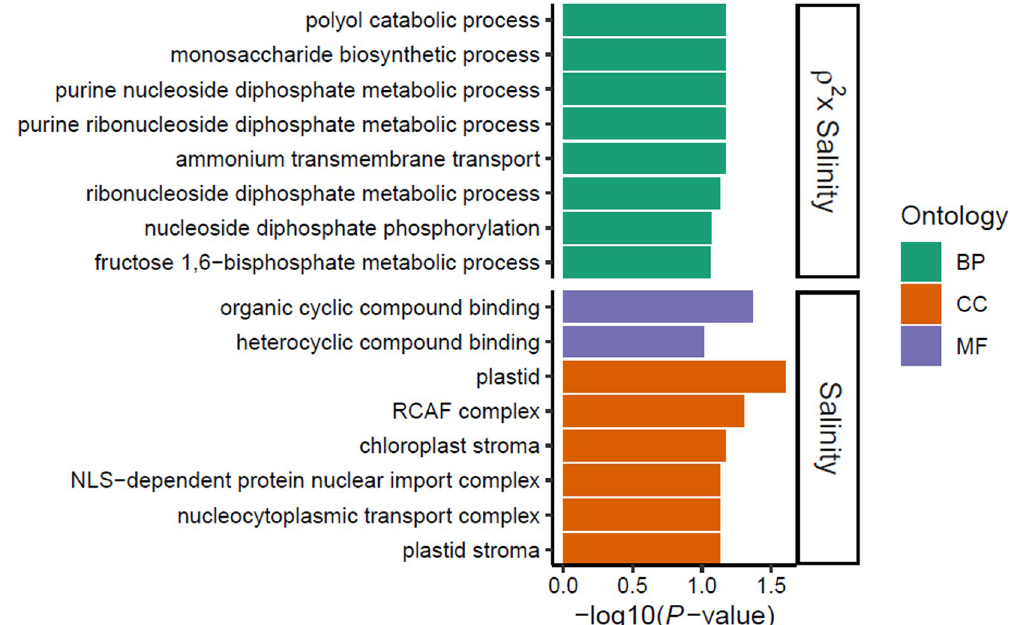
Fig 4. Gene functions involved in salinity-induced plasticity and its evolution. Enriched GO terms of identified DE transcripts between salinities (Salinity) and ρ 2 -specific transcriptional response ( ρ 2 × Salinity). GO categories included MF (purple), CC (orange), and BP (green) and were sorted by decreasing order of evidence within each category based on GO enrichment test P value (for FDR � 0.1). No GO term enrichment with FDR � 0.1 was detected for DE transcripts among evolutionary treatments ( ρ 2 ). The raw data underlying this figure are available in the Figshare repository https://doi.org/10. 6084/m9.figshare.21905670. BP, biological process; CC, cellular component; DE, differentially expressed; GO, Gene Ontology; MF, molecular